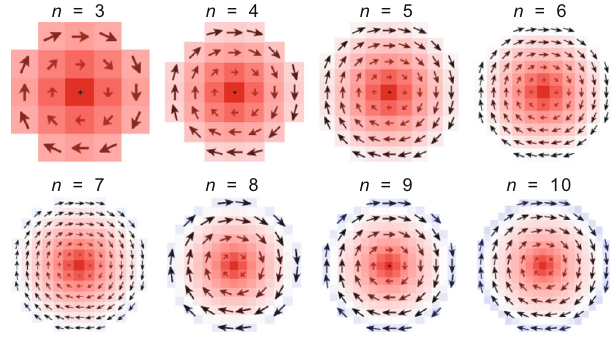
Fig. 2 A simulated state for a meron for radius n = 3, 4, ⋯ , 10. The in- plane spin direction is indicated by the arrow. The out-of-plane spin component is color-coded: white is in-plane and red is out of the plane. The material parameters used in the simulation are: the exchange constant A = 0.32 pJ m − 1 , Dzyaloshinskii – Moriya interaction (DMI) constant ex Fig. 3 Total energy of a meron with p = ± 1 as a function of applied D = 0.5 mJ m − 2 , saturation magnetization M = 152 kA m − 1 , and anisotropy s perpendicular magnetic fi eld B z . The radius of a meron is n = 7. The constant K = − 0.5 MJ m − 3 . More details are given in the “ Methods ” simulation parameters are given in the caption of Fig. 2. More details are section. given in the “ Methods